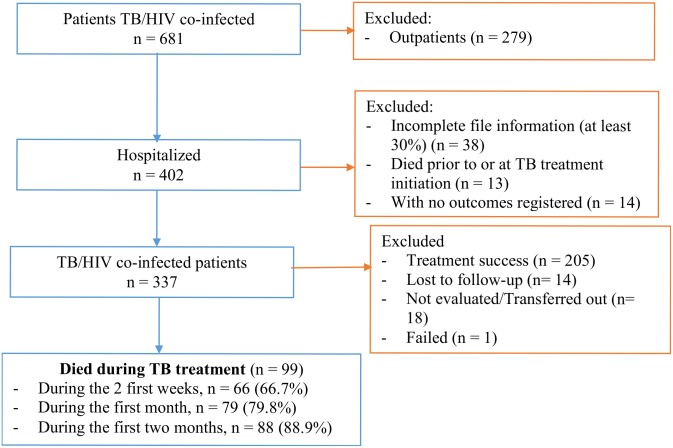
Enrollment of study participants.